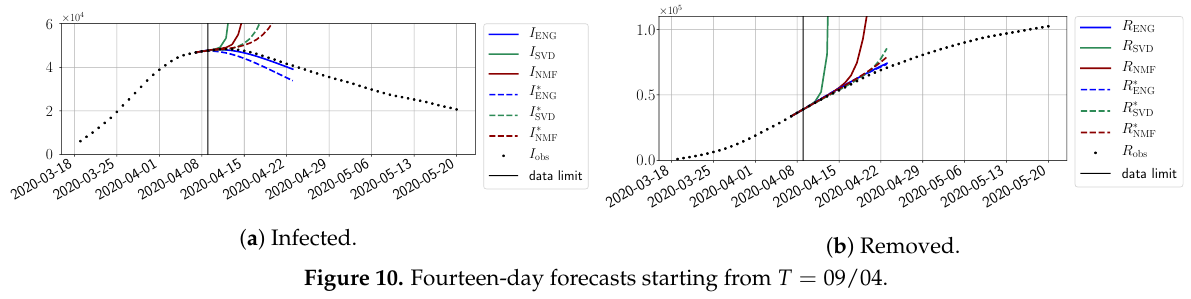
Figure 10. Fourteen-day forecasts starting from T =